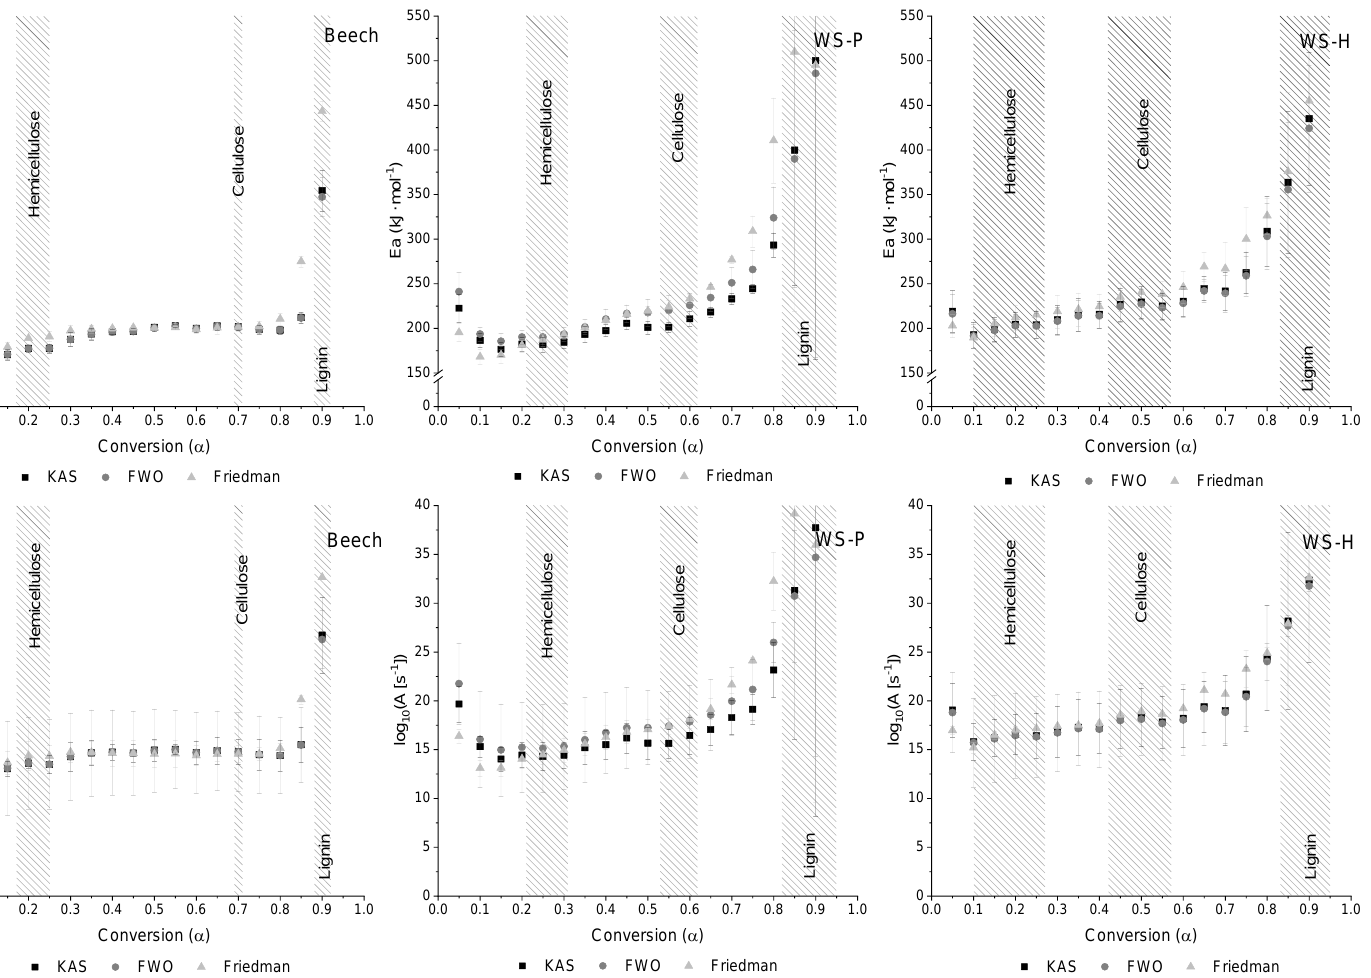
Figure 5. Kinetic parameters obtained using the isoconversional methods. Top: activation energy; bottom: pre-exponential factor. Values for higher conversions were disregarded.